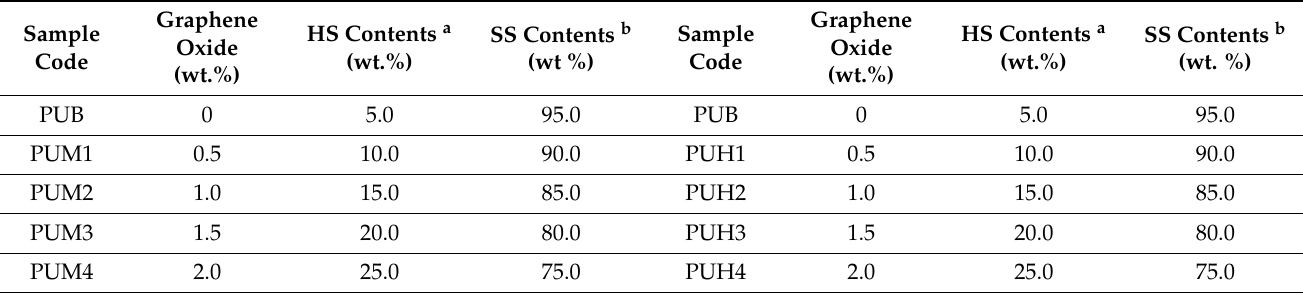
Table 1. A comprehensive description of sample codes and stoichiometry of polyurethane composites containing aro- matic/cycloaliphatic